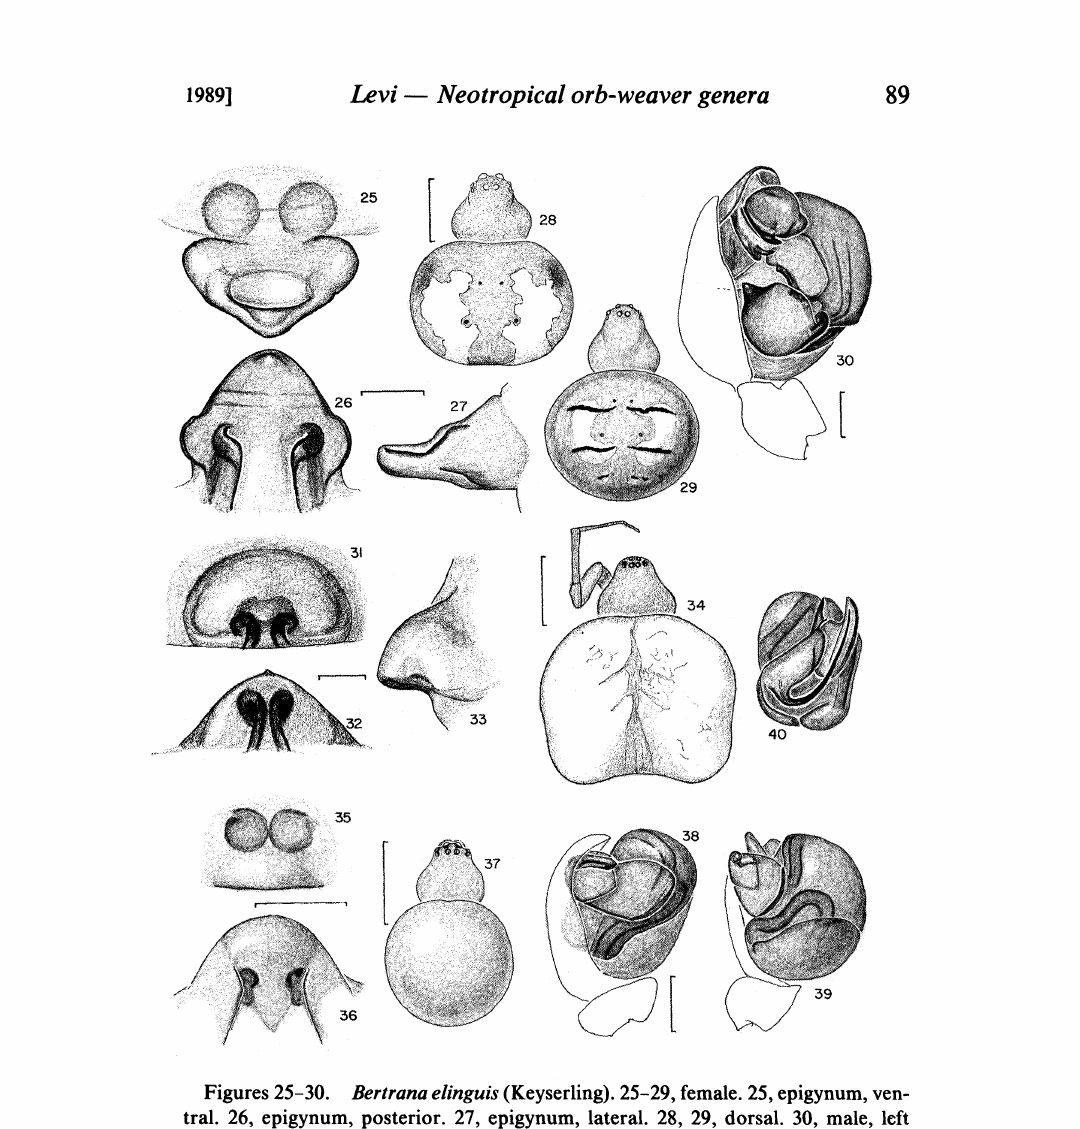
Figures 25-30. Bertrana elinguis (Keyserling). 25-29, female. 25, epigynum, ven- tral. 26, epigynum, posterior. 27, epigynum, lateral. 28, 29, dorsal. 30, male, left palpus. Figures 31-34. B. abbreviata (Keyserling), female. 31, epigynum, ventral. 32, epigynum, posterior. 33, epigynum, lateral. 34, dorsal. Figures 35-40. B. laselva n. sp. 35-37, female. 35, epigynum, ventral. 36, epigy- num, posterior. 37, dorsal. 38-40, male palpus. 38, mesal. 39, ventral. 40, dorsal, cymbium removed. Scale lines. 1.0 mm; genitalia 0.1